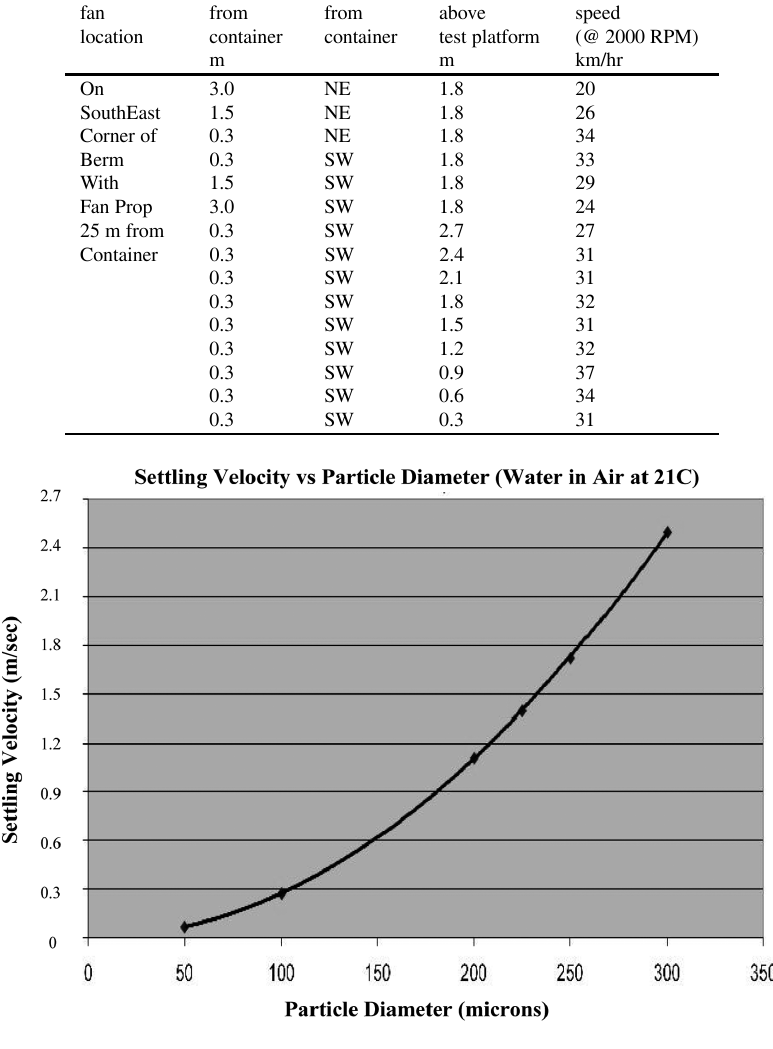
Fig. 6. Particle settling